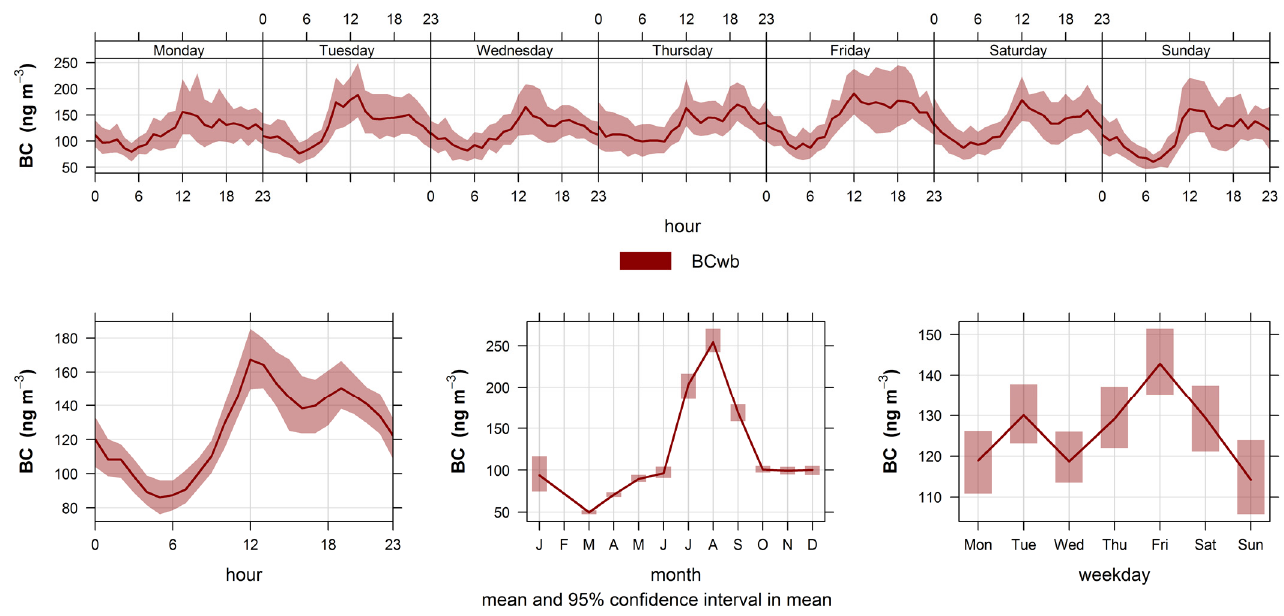
Figure A3. Time variability of BC wb concentrations, 2020 campaign.